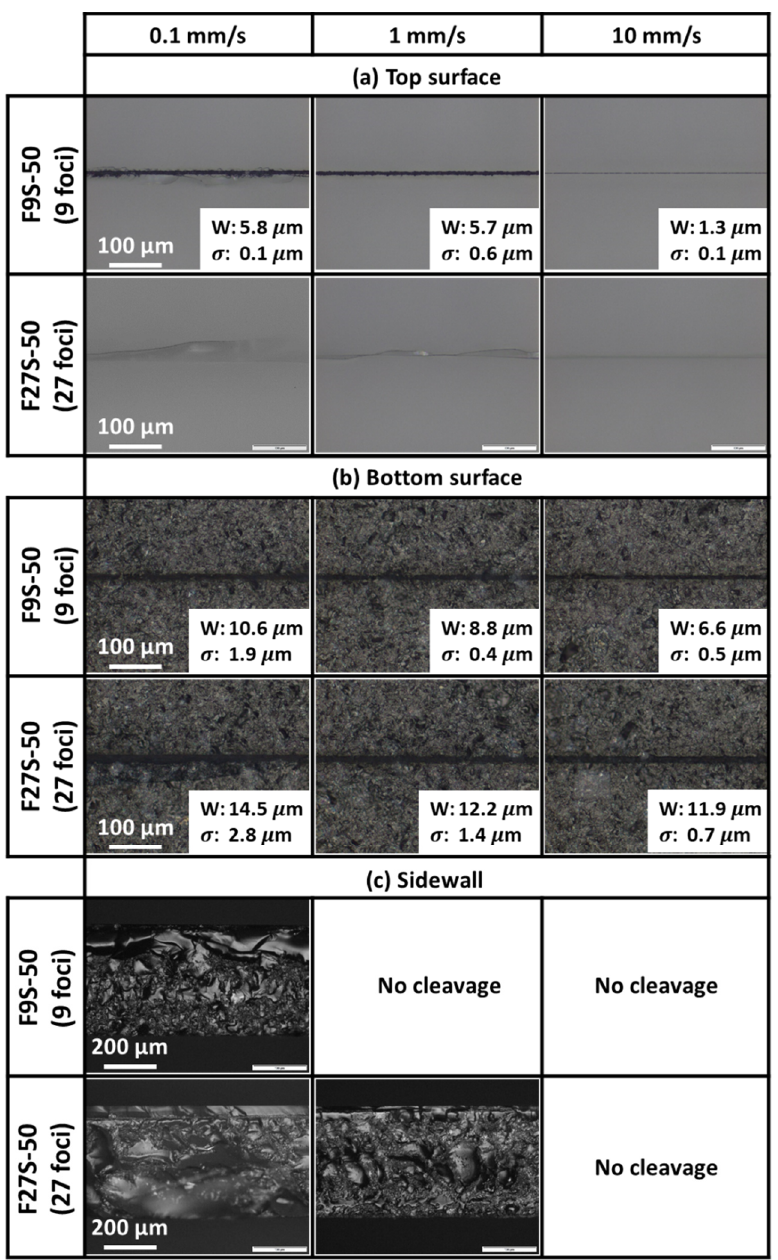
Figure 6. Optical images of ( a ) top polished entry surface, ( b ) bottom unpolished exit surface and ( c ) sidewall profiles after full-section scanning at 1.13 W with the respective widths (W) and standard deviations ( 𝜎 ).